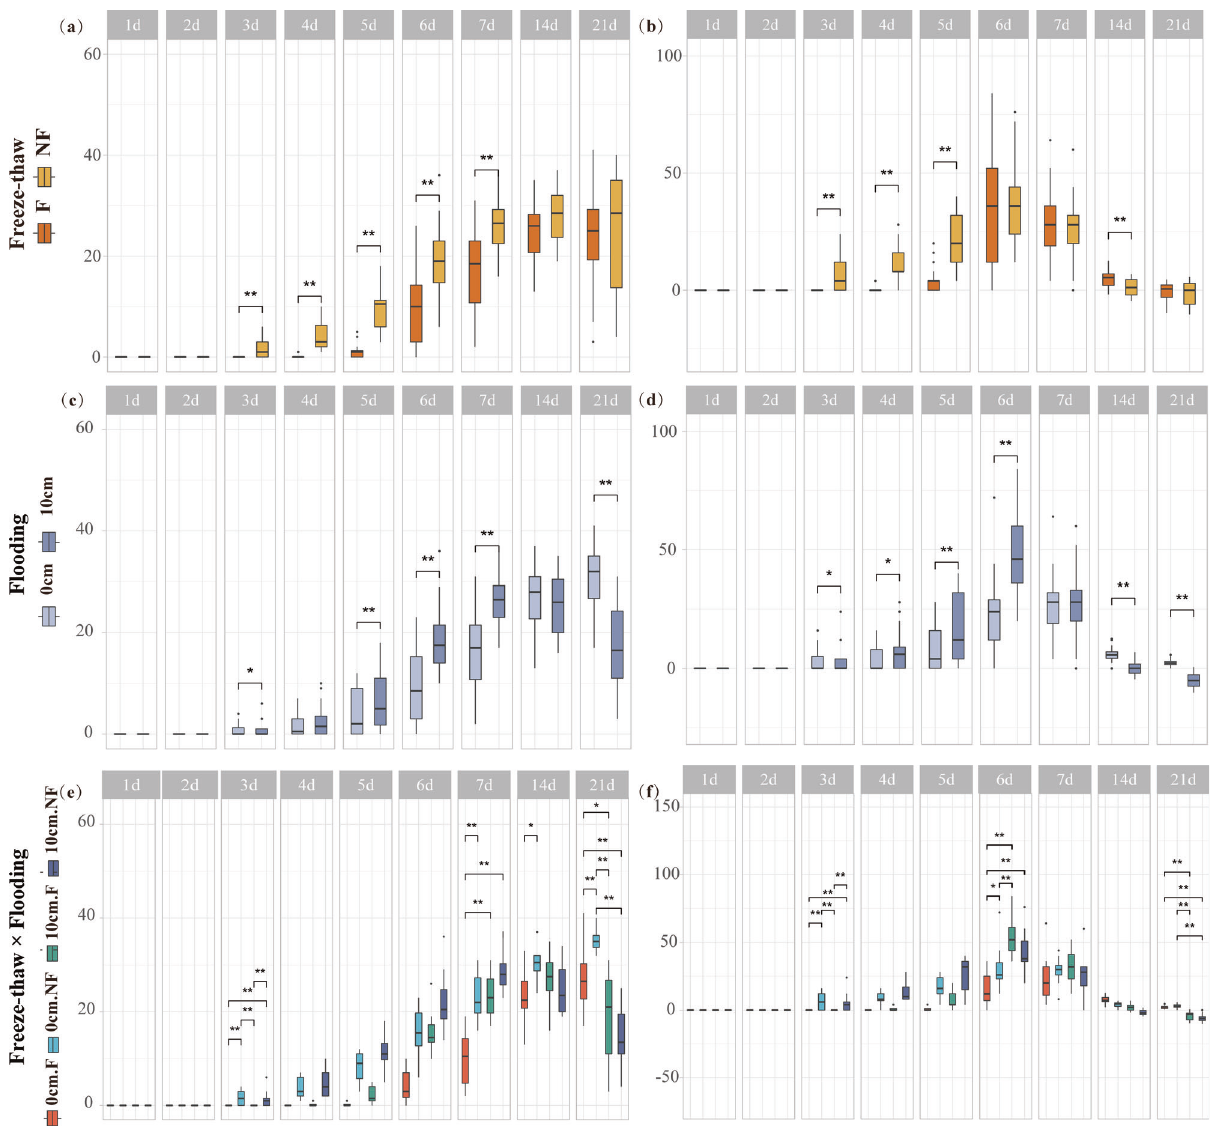
Fig. 1 Plant sprouting responses to the carry-over effects of freeze-thaw under different fl ooding conditions. Five summary statistics are shown in one box plot: The center line indicates the median value, the lower and upper hinges the 25th and 75th percentiles, and the lower and upper whiskers the minimum and maximum of 1.5 times the interquartile range. Furthermore, the dots in box plots denote samples that are outside of 1.5 times the interquartile range. Post hoc analysis was performed when interaction effects existed between freeze-thaw and fl ooding. ( a , c , e ) Sprouting number; ( b , d , f ) sprouting speed (% day − 1 ); ** p < 0.01; * p < 0.05; 0 cm: non- fl ooding; 10 cm: fl ooding; F: freeze-thaw treatment; NF: control; 0 cm. F: non- fl ooding × freeze-thaw; 0 cm. NF: non- fl ooding × control; 10 cm. F: fl ooding × freeze-thaw; 10 cm. NF: fl ooding ×